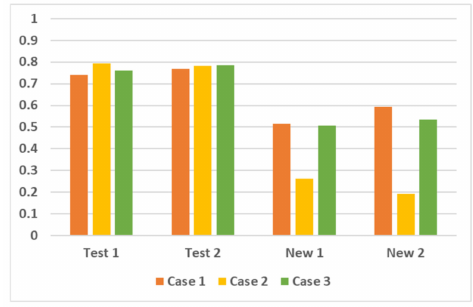
Figure 30. Graphical representation of Table